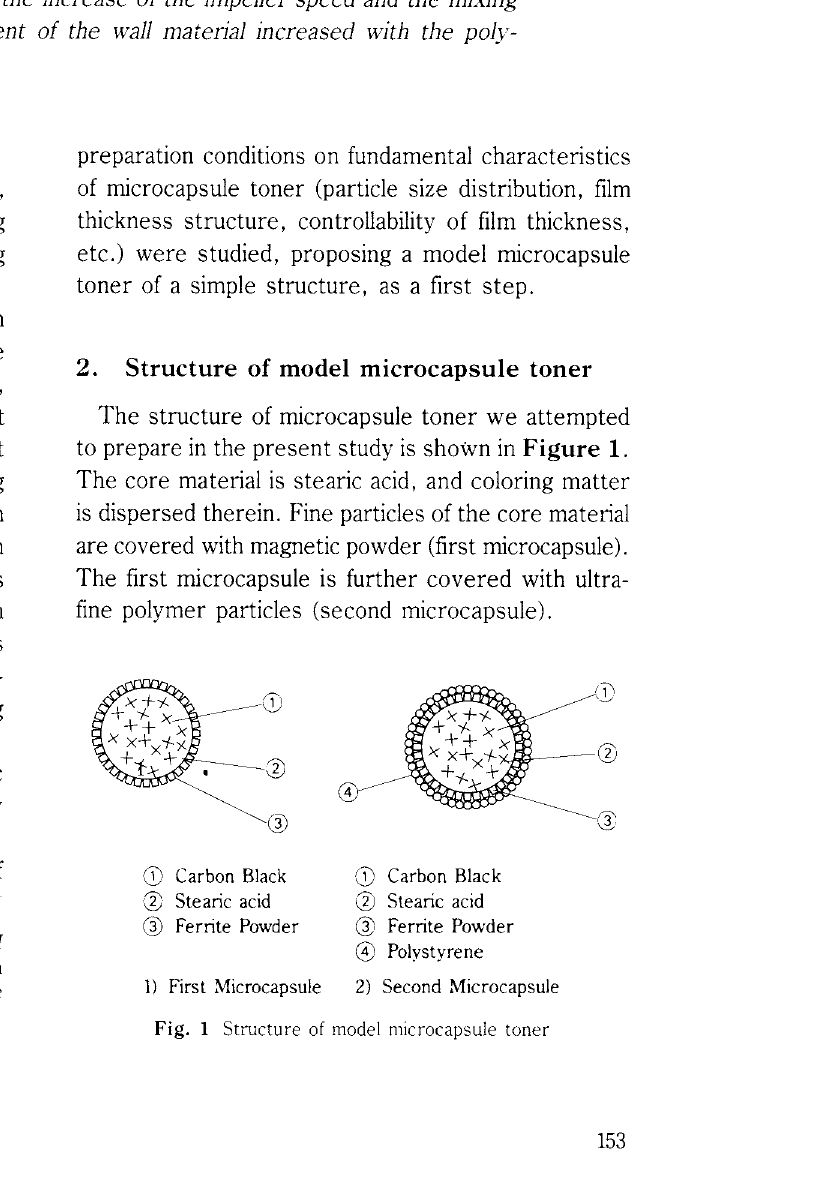
Fig. 1 Structure of model microcapsule